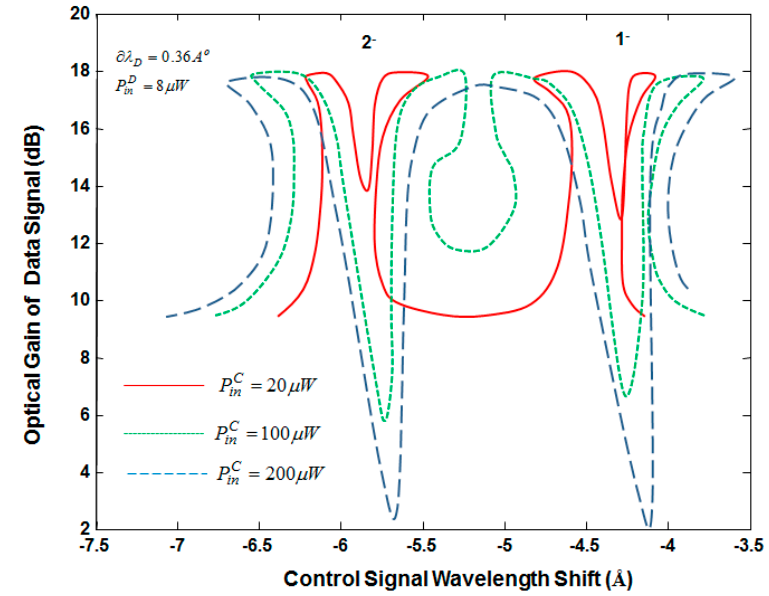
Figure 5. Optical gain of data signal as a function of control-wavelength shift at fixed input.